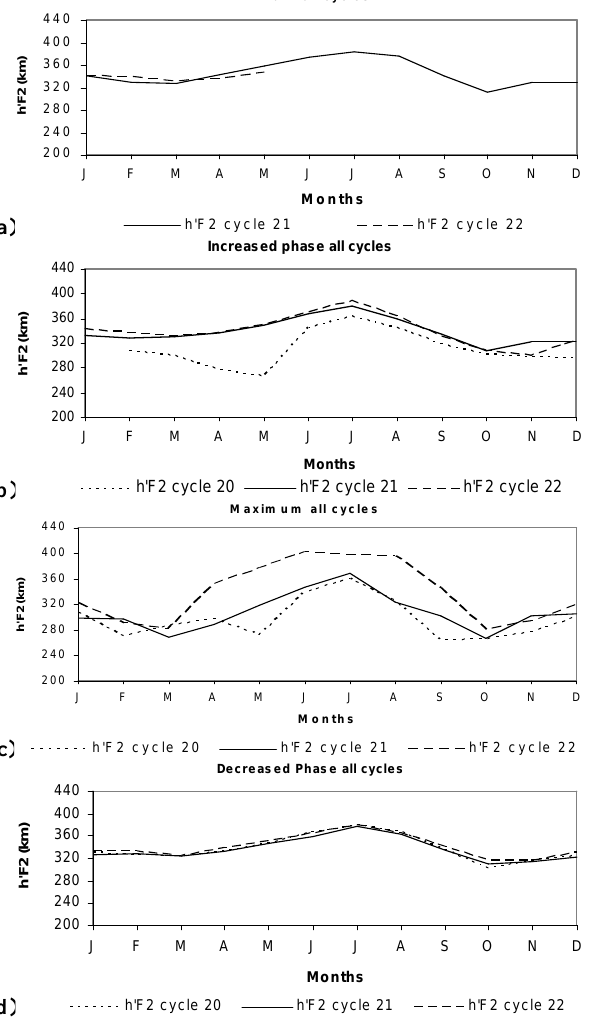
Fig. 7. Similar to Fig. 3 for h 0 E.